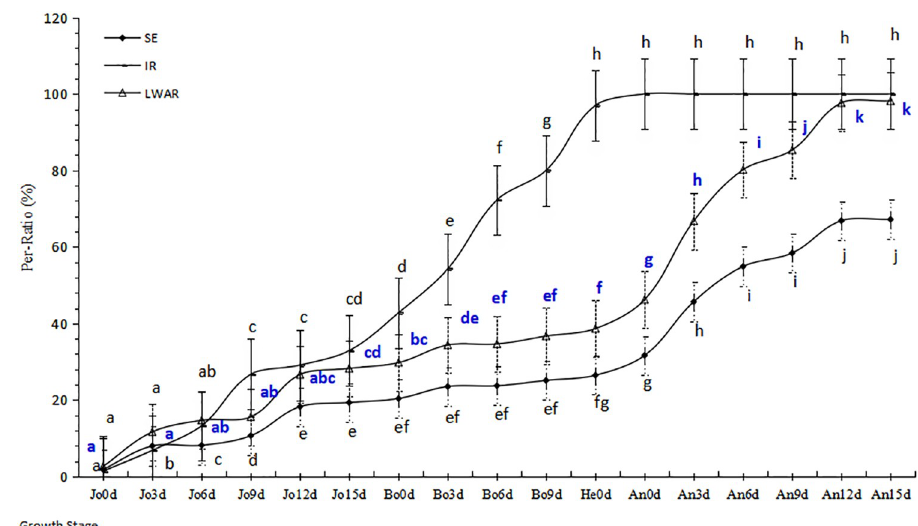
Fig 1. Dynamic of developing and damage. Note: 1) The letters of the dynamic line mean there were significant differences at the level of 0.05, while the same letters mean no difference. 2) GS means growth stages. As is the follows.